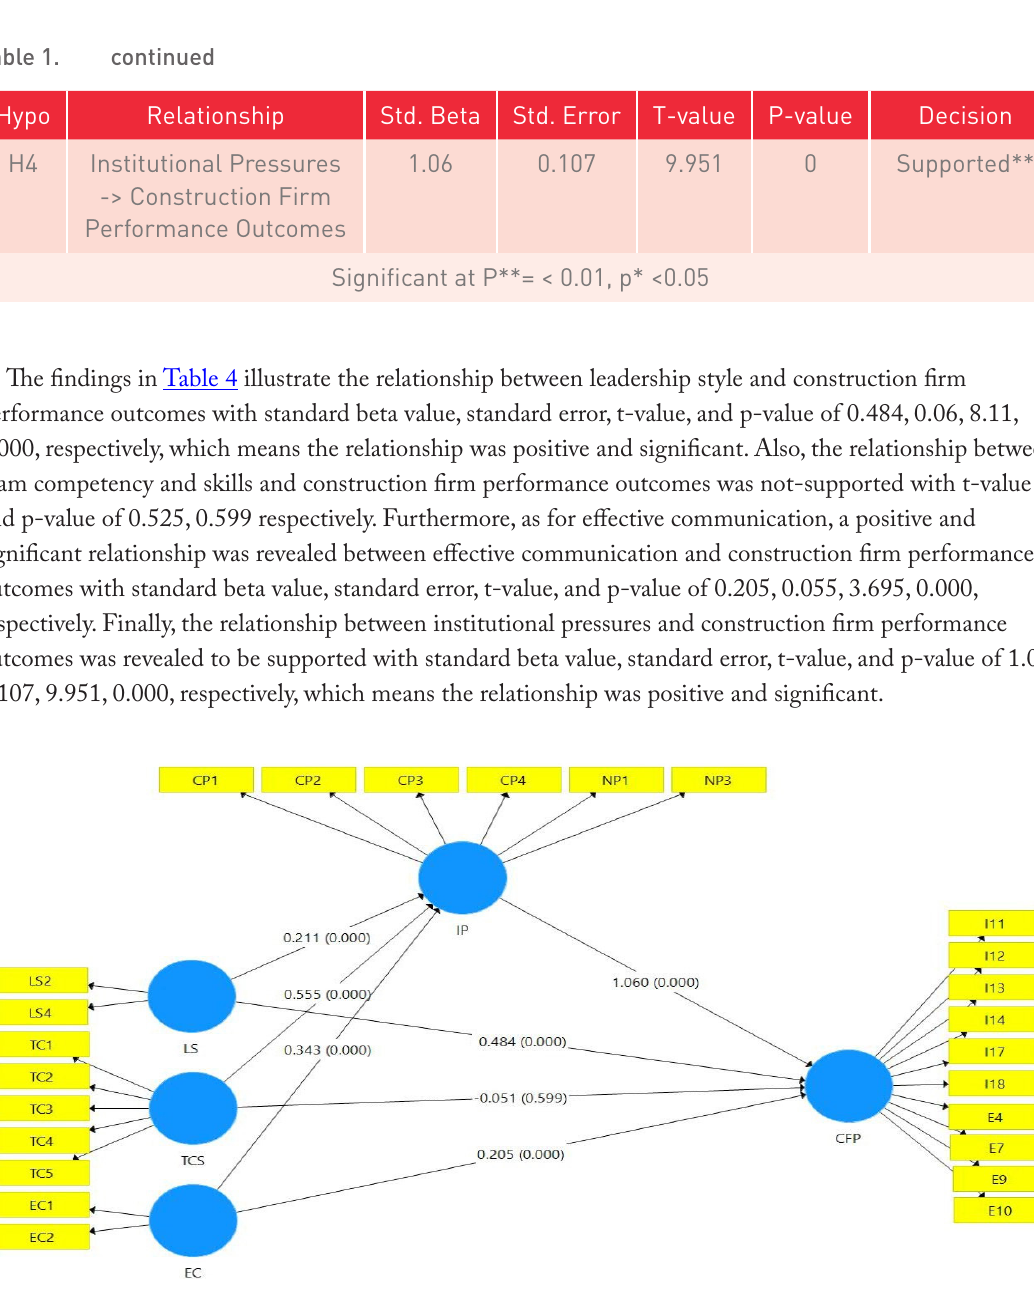
Figure 6. Structural Model (Path coefficient and